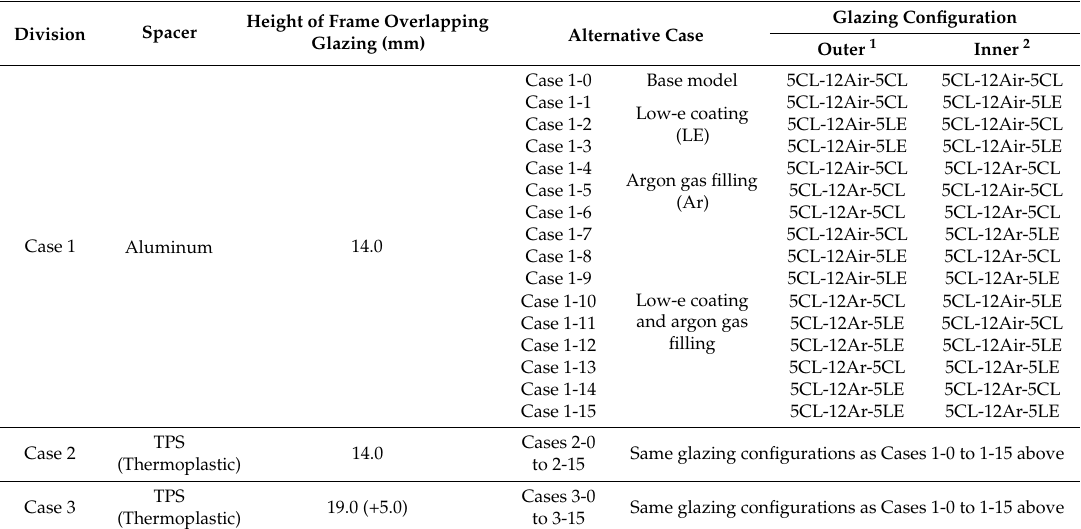
Table 2. Base model and alternatives.